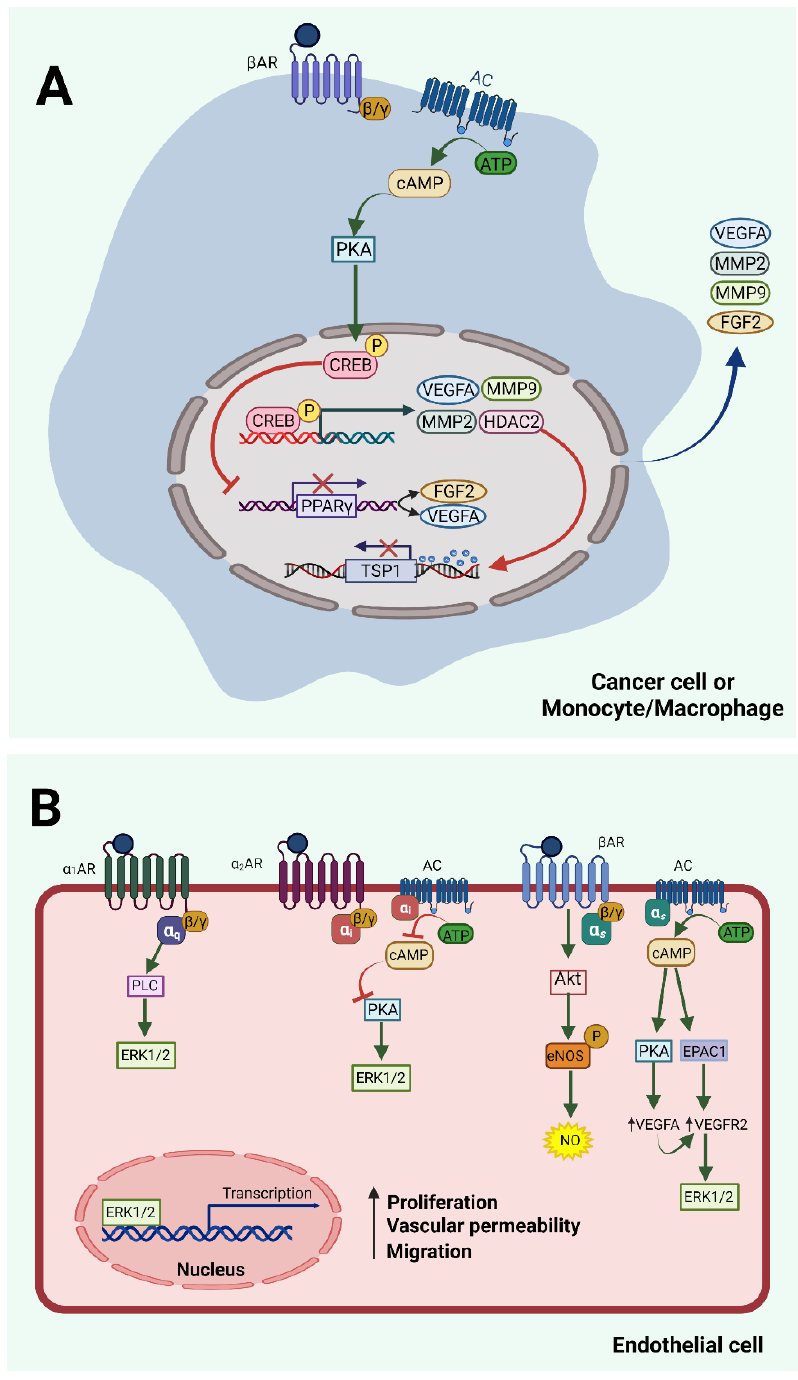
Figure 1. Adrenergic signaling in endothelial and other cells that regulate angiogenesis. ( A ) Indirect regulation. Norepinephrine and/or epinephrine reach the microenvironment of cancer or blood or other cells through the local sympathetic nerves or the bloodstream and bind to β ARs, thus activating the AC/cAMP/PKA pathway. PKA phosphorylates the transcription factor CREB, which induces the transcription of multiple pro-angiogenic factors, such as MMP2 and MMP9, VEGFA, and HDAC2. Secreted MMPs destabilize the extracellular matrix, releasing growth factors and allowing cancer cell metastasis and angiogenesis. Secreted VEGFA binds to VEGFR2 on neighboring endothelial cells and enhances their pro-angiogenic phenotype. Similarly, FGF2 and other secreted proangiogenic growth factors stimulate endothelial cells through their specific receptors. HDAC2 epigenetically inhibits